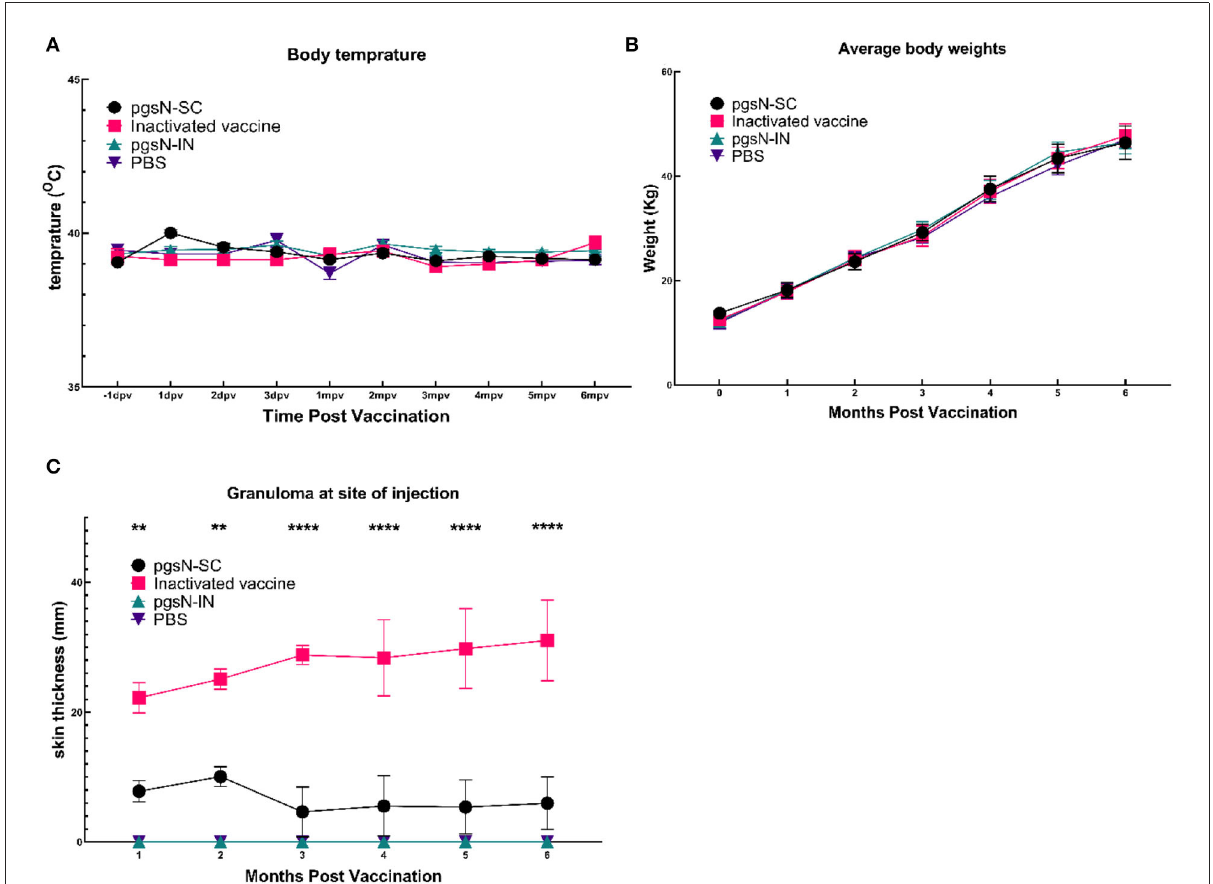
FIGURE3 Safety of pgsN vaccine. (A) The average body temperatures at 1 day before vaccination, the first 3 days post vaccination as well as every month post vaccination. (B) The average weights for each group throughout the study timeline. (C) The average size of the granuloma at the site of injection. Bars represent the standard error asterisks indicate statistical significance between pgsN-SC and inactivated vaccines using Student t -test. **, p -value < 0.01; ***, p -value < 0.001; ****, p -value < 0.0001.